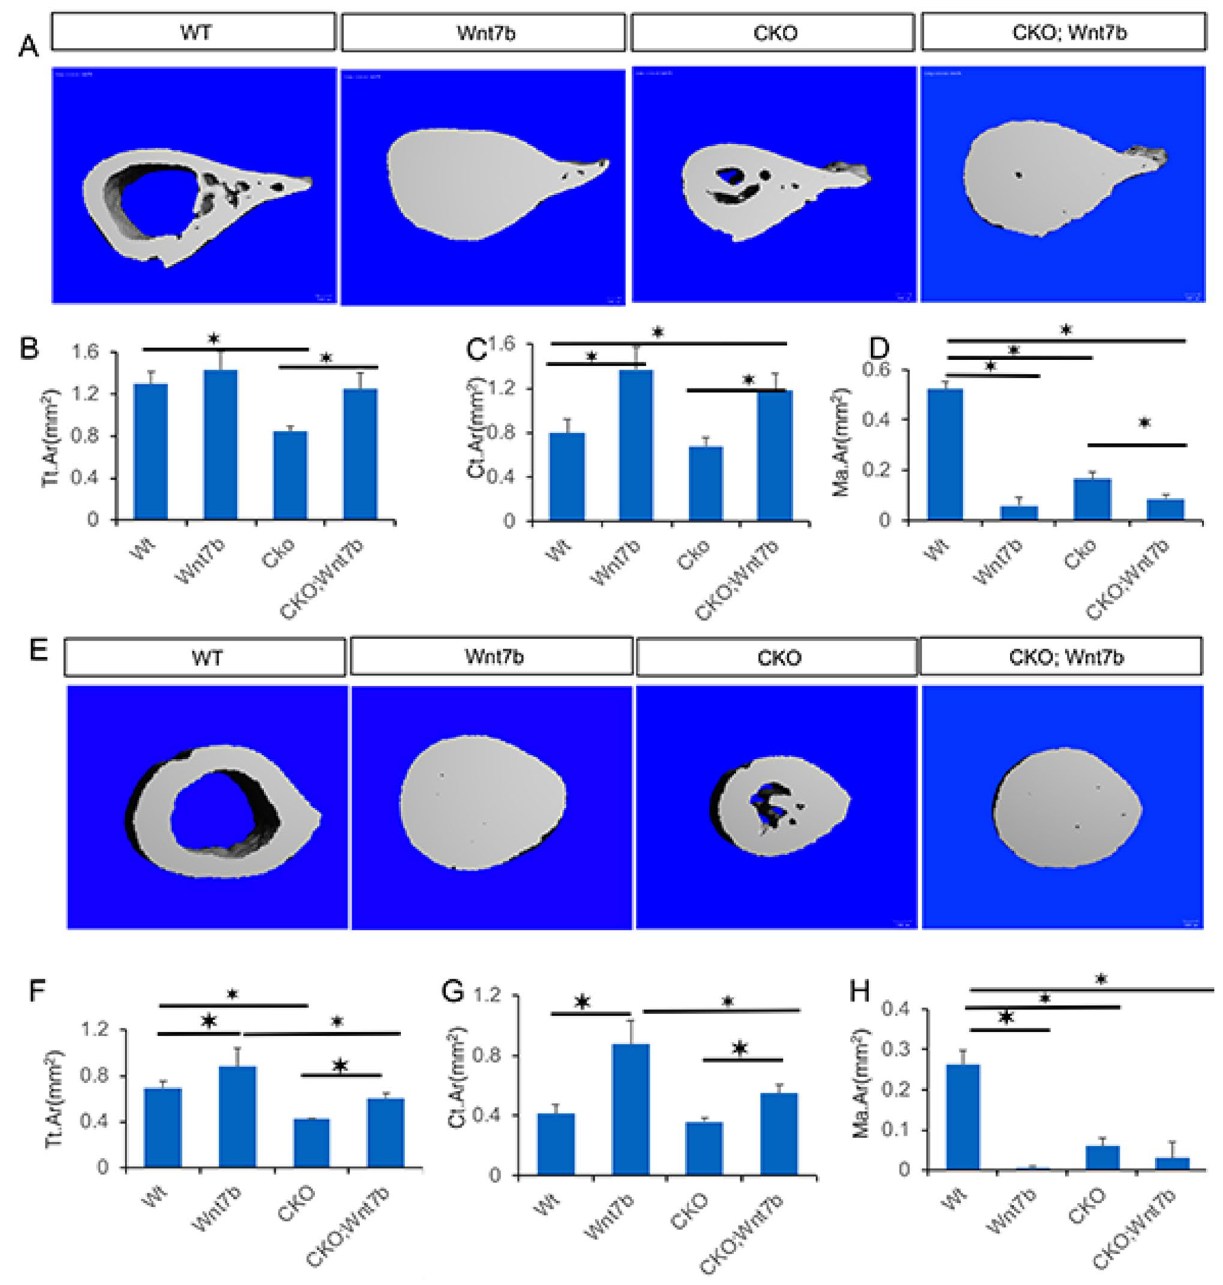
Figure 3. Overexpression of Wnt7b rescues diminished bone size in Bmpr1a-deficient mice. ( A ) Representative 3D reconstruction of cross-sectional μCT images at the proximal femur in littermate mice at P33. ( B – D ) μCT quantification of cortical bone parameters in the proximal femur. *: P < 0.05, two-way ANOVA, n = 5 (4 females, 1 male). ( E ) Representative 3D reconstruction of cross-sectional μCT images of the tibia immediately above the tibiofibular junction. ( F – H ) μCT quantification of cortical bone parameters of the tibia immediately above tibiofibular junction. *: P < 0.05, two-way ANOVA, n = 6 (4 females, 2